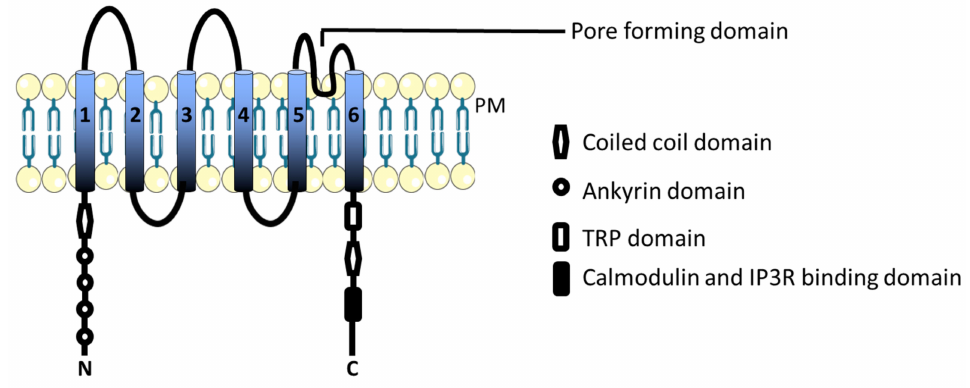
Figure 3. TRPC channel transmembrane structure and the domain organization of the